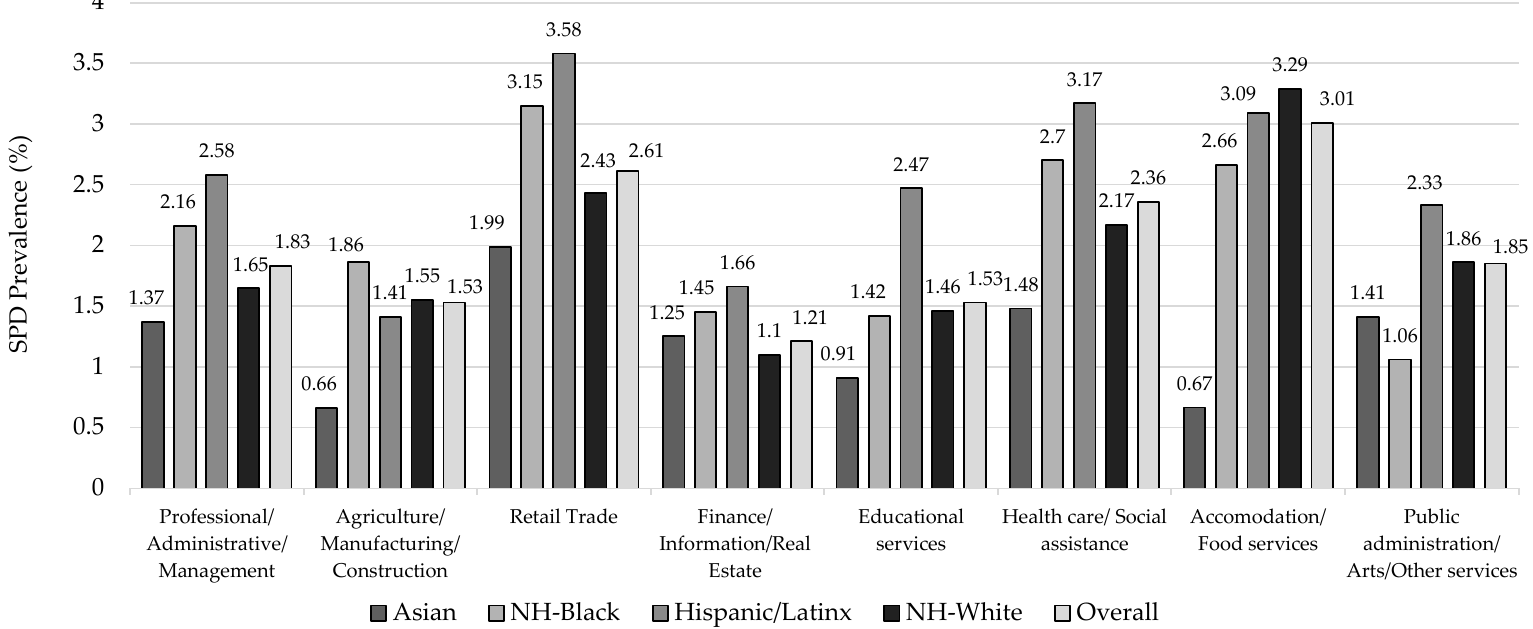
Figure 1. Age-Standardized a Prevalence of Serious Psychological Distress (SPD) by Industry of Employment among U.S. Adults Overall and by Race/Ethnicity, National Health Interview Survey, 2004–2018 (N = 245,038). a All estimates are weighted for the survey’s complex sampling design. All estimates except for age are age-standardized to the U.S. 2010 population. Professional/Administrative/Management includes the following NAICS (NAICS Association, LLC, Rockaway,